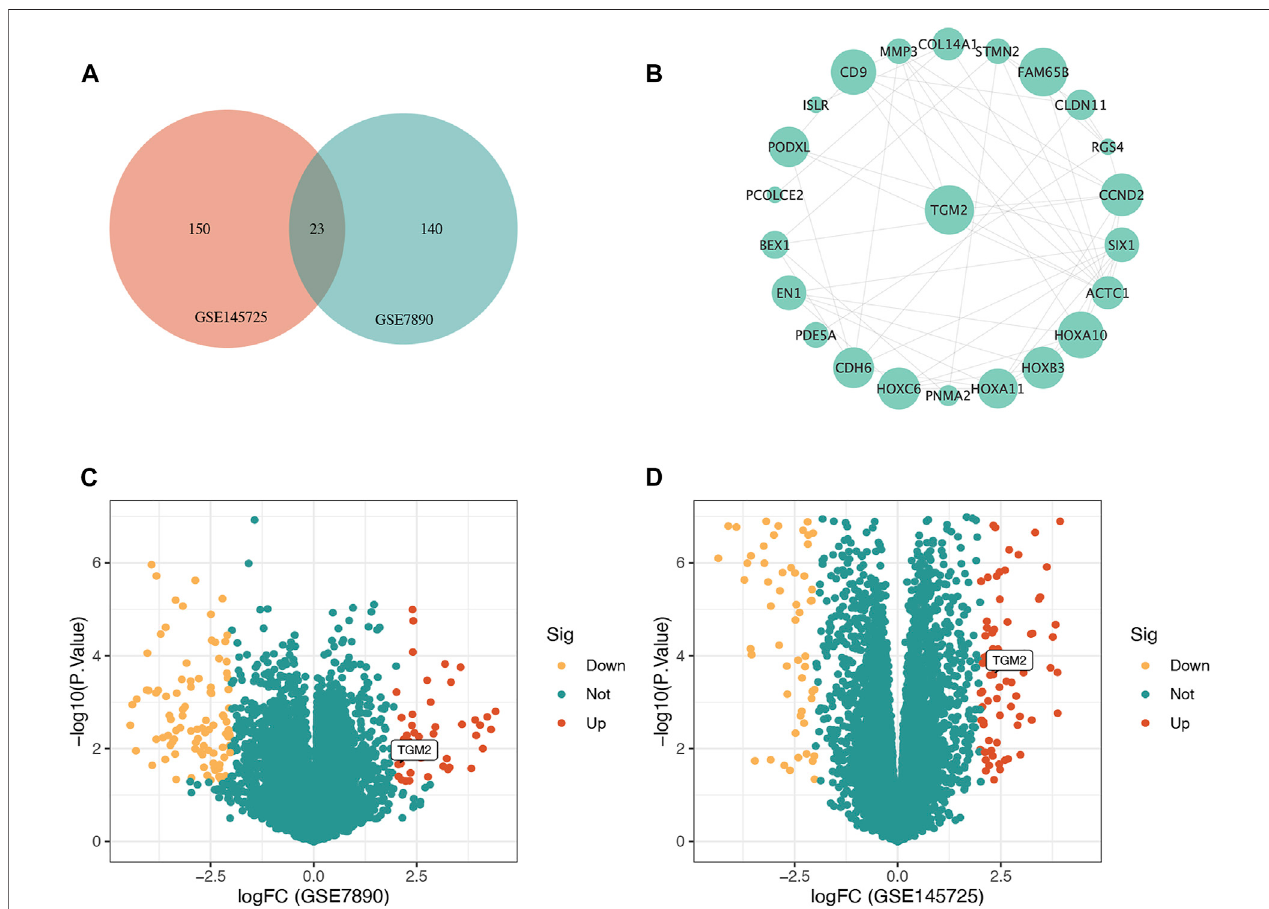
FIGURE 2 | Illustration of the identi fi cation of the hub gene in keloid. (A) Venn diagram demonstrating the intersection of differentially expressed genes (DEGs) in GSE7890 and GSE145725. (B) Protein-protein interaction network constructed based on STRING database and Cytoscape software for DEGs shared by GSE7890 andGSE145725,andTGM2withthehighestconnectivitywasselectedasthekeygene. (C) VolcanomapofDEGsoftheGSE7890dataset. (D) VolcanomapofDEGsof the GSE145725 dataset. Red represents up-regulated genes, green represents non-signi fi cant genes, and yellow represents down-regulated